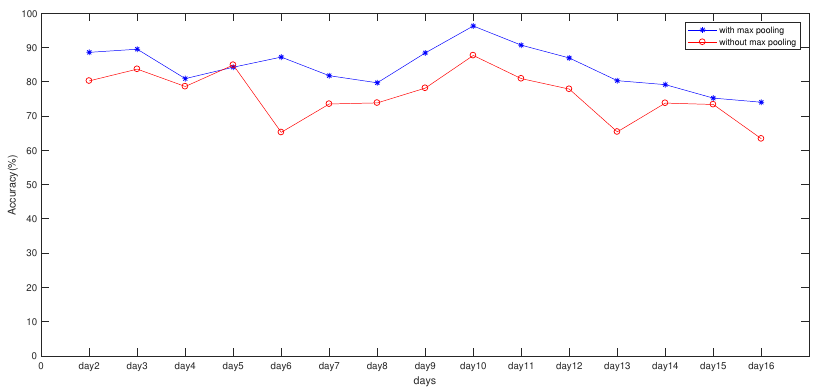
Figure 9. Comparison between experiment results with and without Max